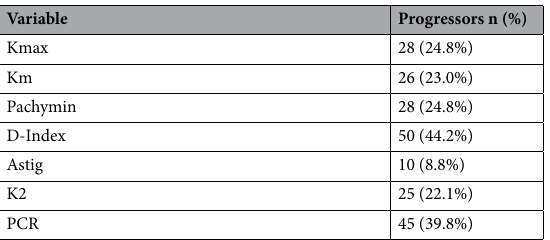
Table 2. Absolute and relative frequencies of keratoconus progressing eyes when considering each progression parameter alone. Kmax maximum keratometry, Km mean keratometry, PachyMin minimum pachymetry,